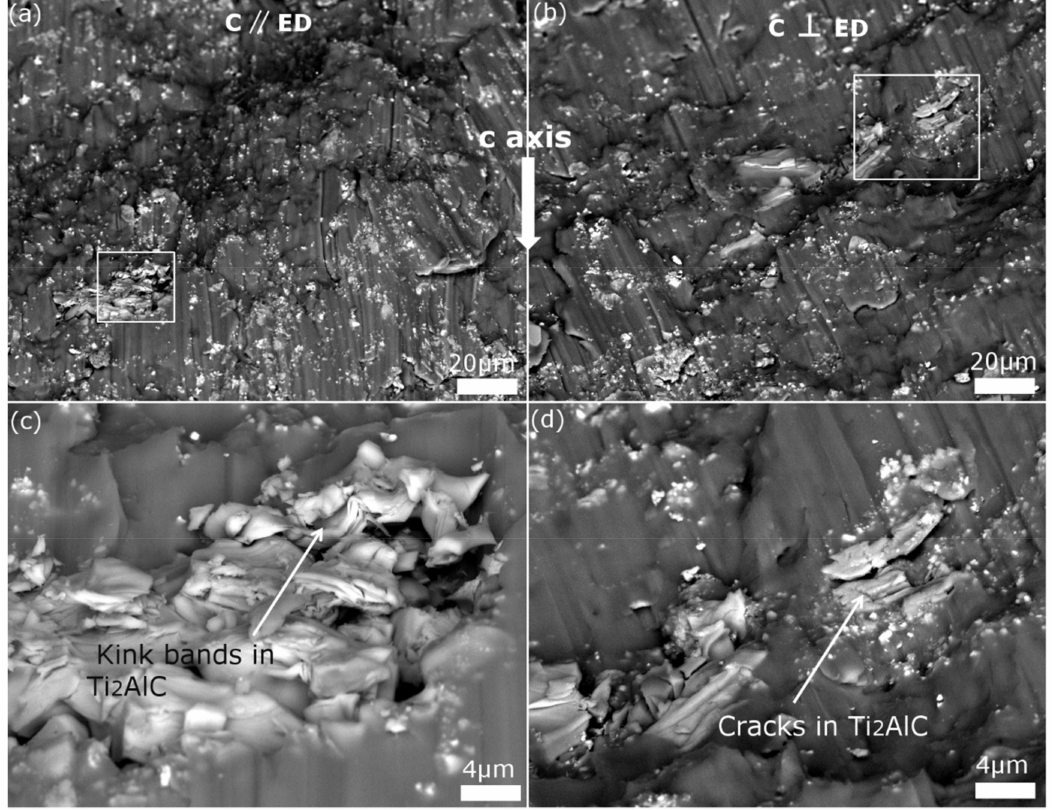
Figure 7. ( a ) and ( b ) Fracture compressive surfaces of the C // ED and C ⊥ ED specimens, ( c ) and ( d ) enlarged area marked by rectangular in ( a ) and ( b